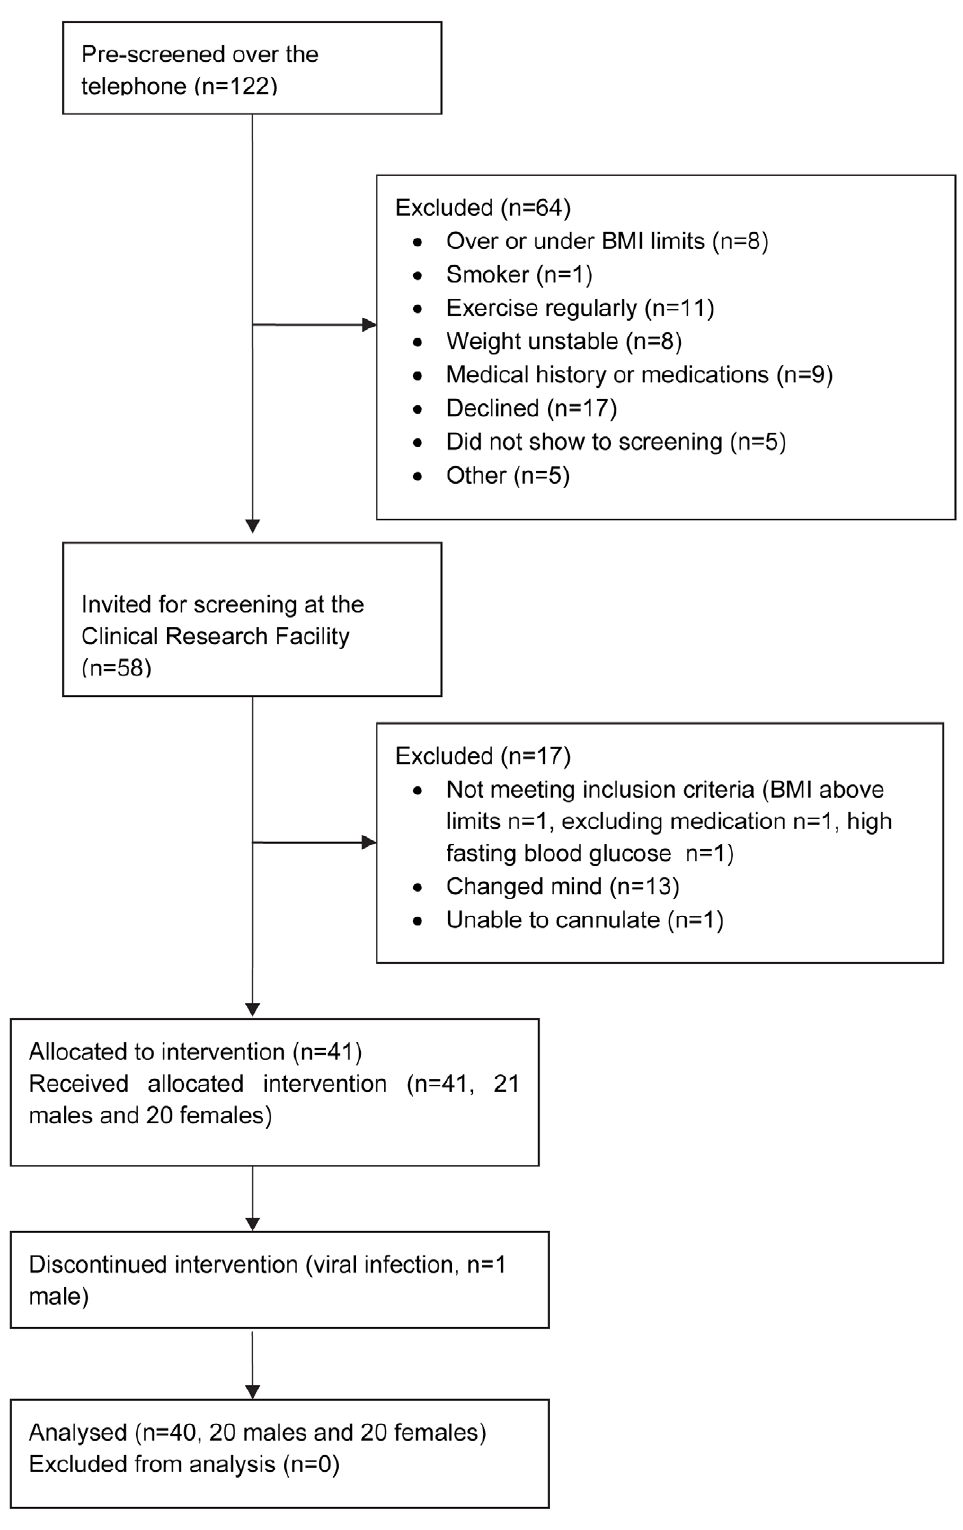
Figure 1. Flow of participants in the study.